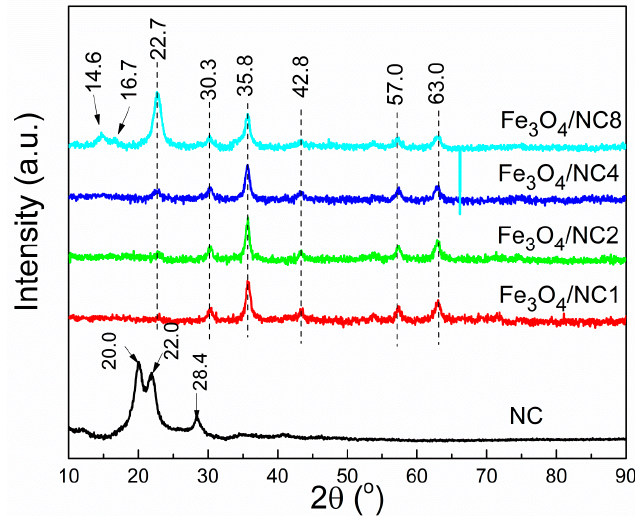
Figure 1. Diffractograms of NC and NC/Fe 3 O 4 samples.